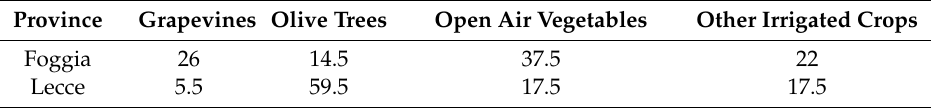
Table 1. Irrigated crop pattern (percentage of the total irrigated area).